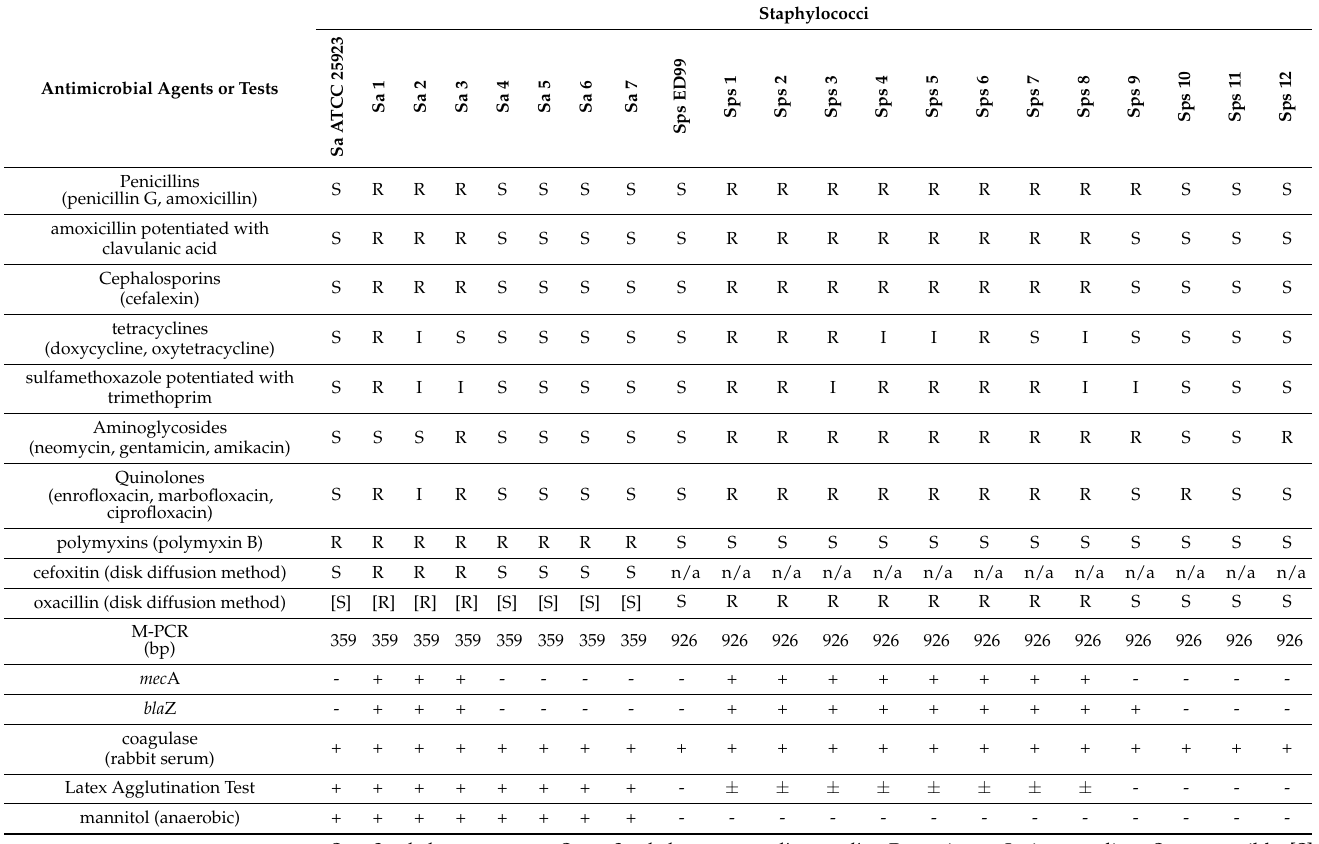
Table 1. Susceptibility testing (the disk diffusion method) and other differentiation tests for all staphylococci strains under